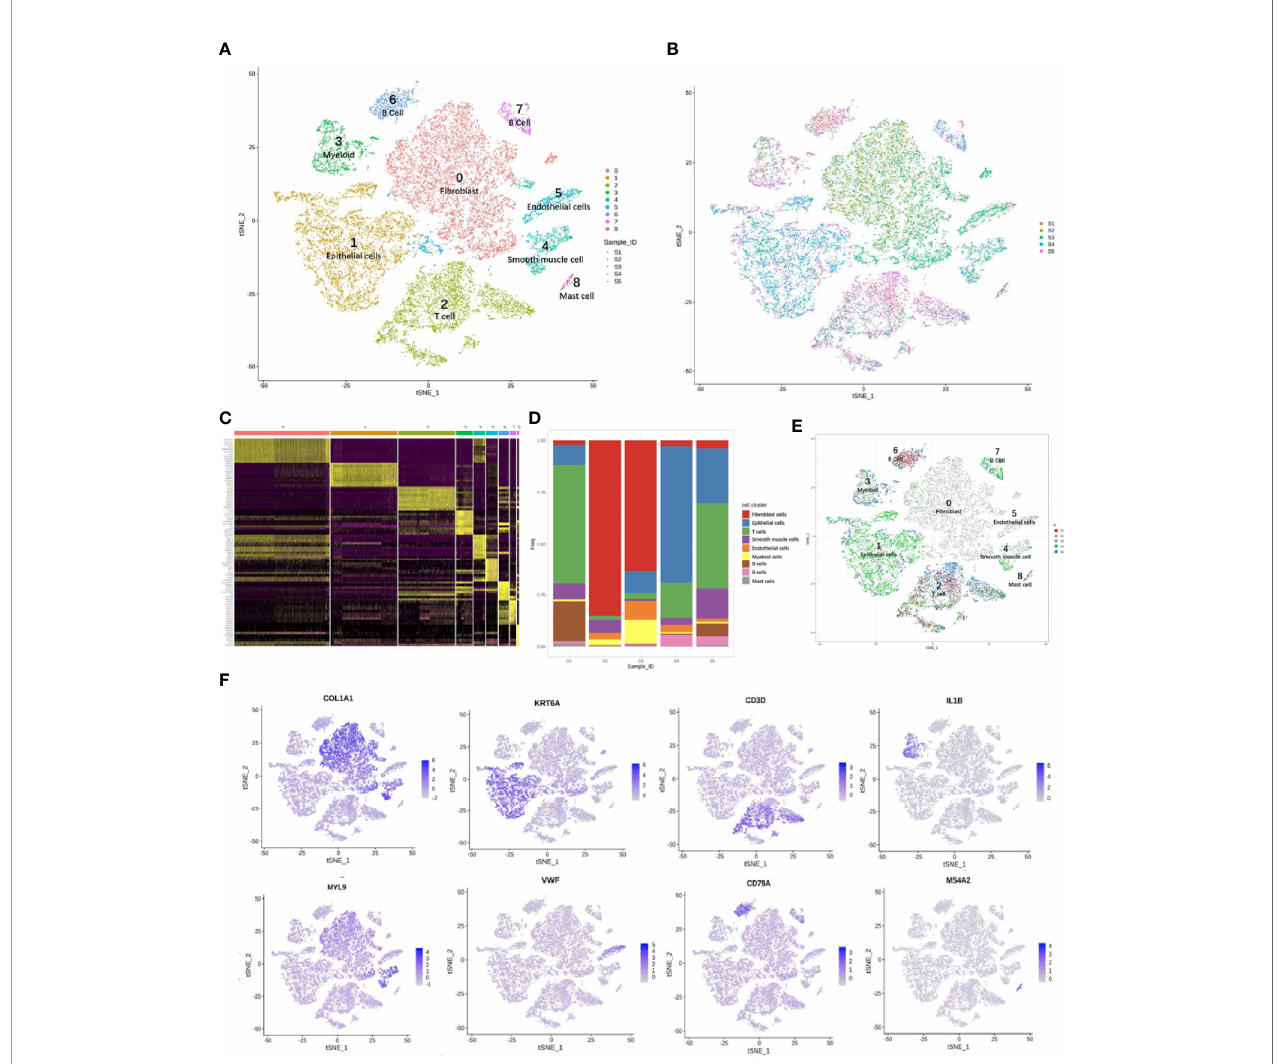
FIGURE 3 | Overview of 24,371 cells from fi ve cervical cancer tissues. t -Distributed stochastic neighbor embedding ( t -SNE) plots displaying 24,371 cell pro fi les with each cell color-coded for (A) associated cell type and (B) its sample origin. (C) Heatmap shows differentially expressed marker genes (rows) in nine clusters. Yellow and dark purple: high and low expression, respectively. (D) Proportions of cells in each sample. (E) t -SNE plots displaying 24,371 cell pro fi les with color-coded sample origins. Samples 2 and 3 are gray. (F) t -SNE plot color-coded for marker gene expression (gray to white to blue) for COL1A2 (cluster 0, C0), KRT6A (C1), CD3D (C2), IL1B (C3), MYL9 (C4), VWF (C5), CD79A (C6 and C7), and MS4A2